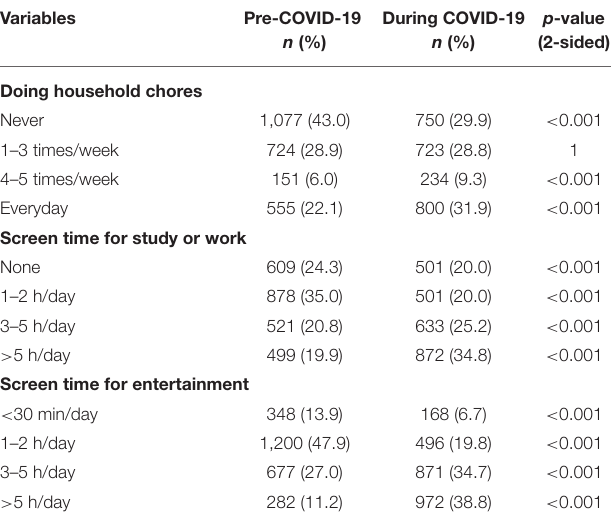
TABLE 6 | Daily activities pre-and during COVID-19 pandemic ( n =